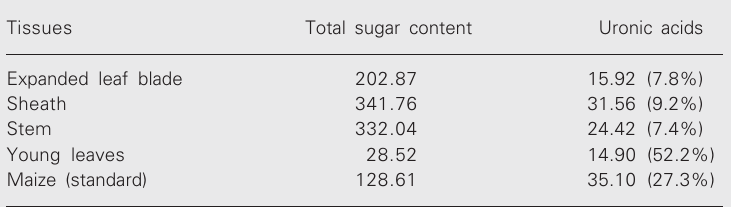
Table 1. Yield of neutral sugars and uronic acids in the 4 M KOH fractions obtained from different parts of the plant of Rhynchelytrum repens